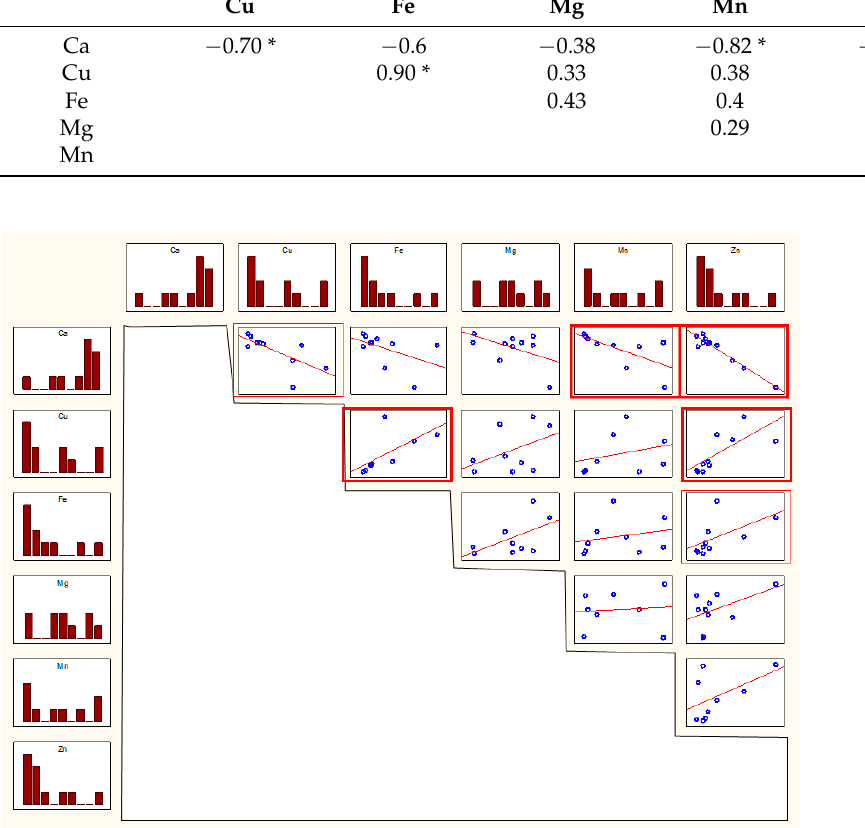
Figure 4. Scatterplot for pairs of elemental parameters in women. Thick frame— p < 0.01, thin frame— p < 0.05. Table 2. The values of the correlation coefficients for the content of analytes in the tissue of women. Statistically significant values are marked with an asterisk.